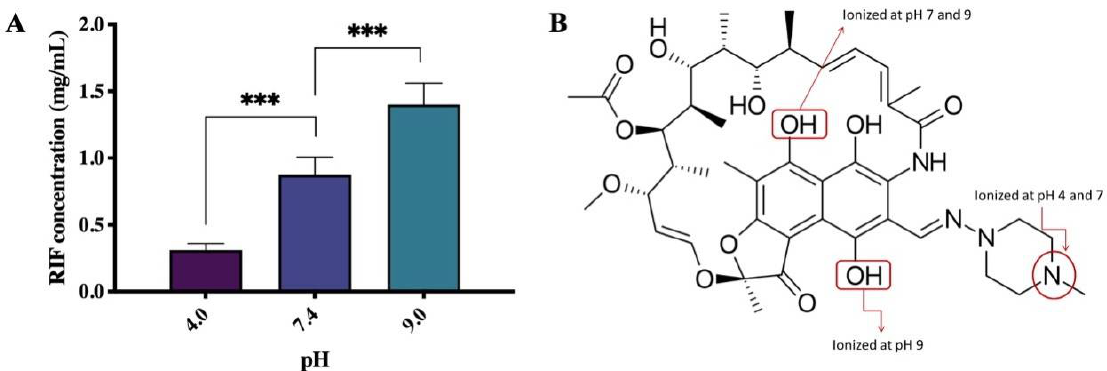
Figure 2. ( A ) RIF solubility at a range of buffer pH values (means + SD, n = 12) and ( B ) RIF structure showing the ionizable groups. Differences were calculated using one-way ANOVA, Tukey’s post hoc test, and deemed significant at where p -value outputs were 0.033 (*), 0.002 (**), <0.001 (***) and <0.0001 (****).